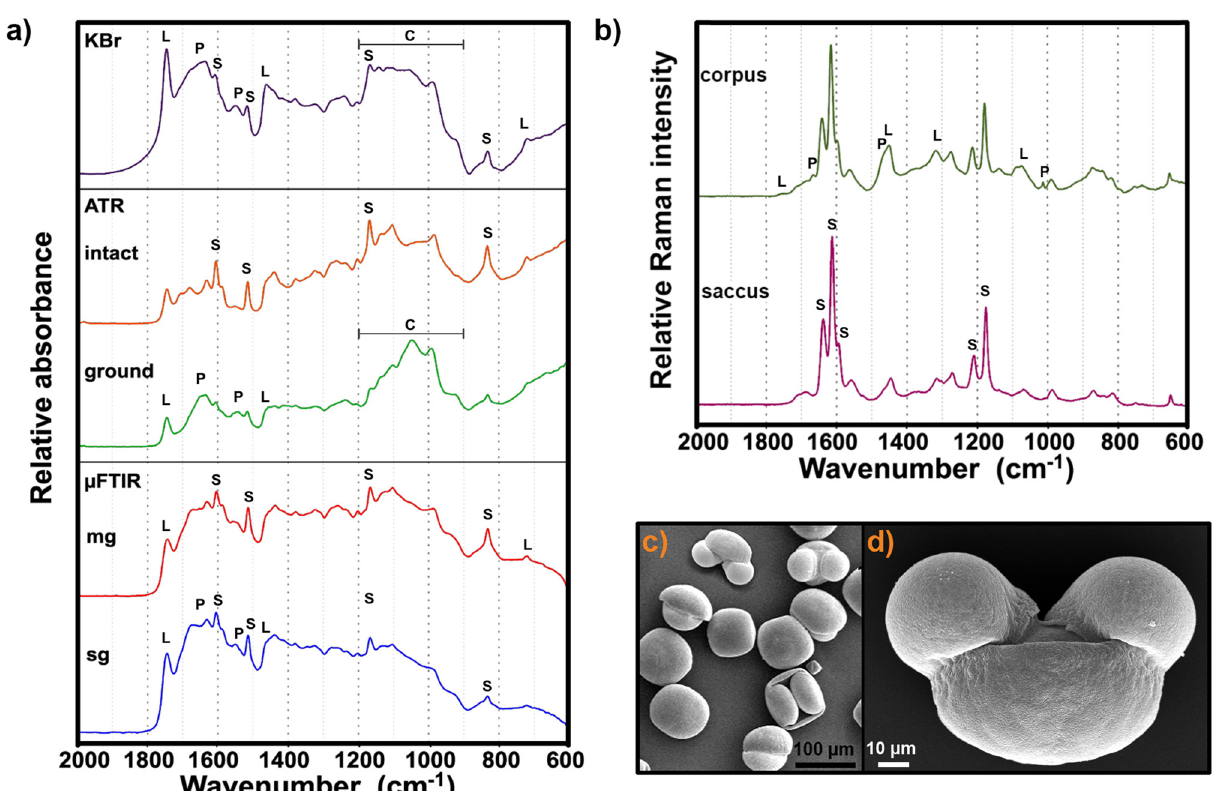
Fig 1. Measurement of Abies cephalonica pollen. (a) FTIR spectra obtained from different sampling techniques (from top downwards): transmission IR of KBr pellet, ATR-IR of intact and ground grains, IR microspectroscopy of multigrain (mg) and single grain (sg). (b) Raman spectra obtained from two different regions of a single grain: corpus and saccus regions. The marked signals are associated with the vibrational bands of (P) proteins, (L) lipids, (C) carbohydrates and (S) sporopollenins. (c) SEM image of pollen grains in various orientations: equatorial view (up left), distal polar view (up right) and proximal polar view (down left). (d) SEM image of pollen grain in equatorial view, with saccus (up, two hemispherical substructures) and corpus regions (down, large hemispherical substructure).